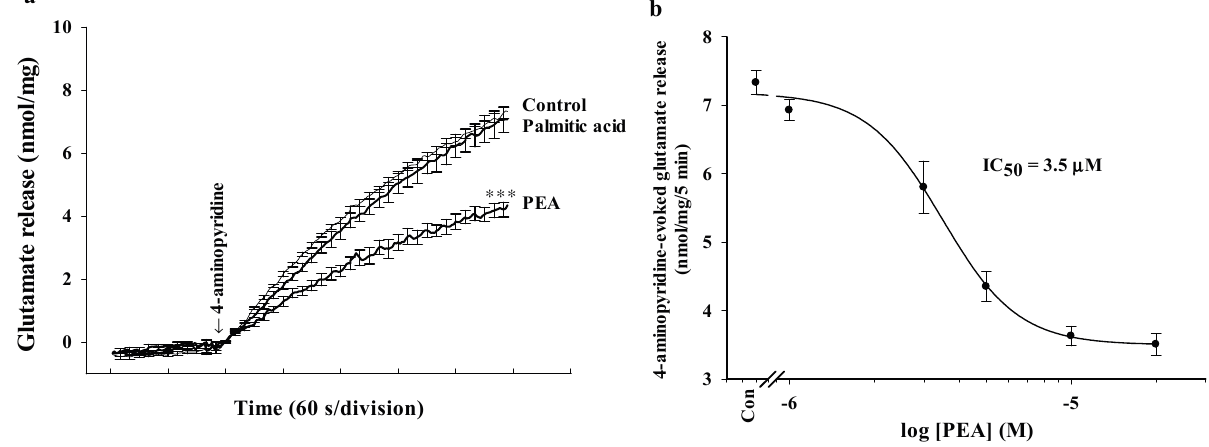
Figure 1. Palmitoylethanolamide (PEA) inhibits 4-aminopyridine-evoked release